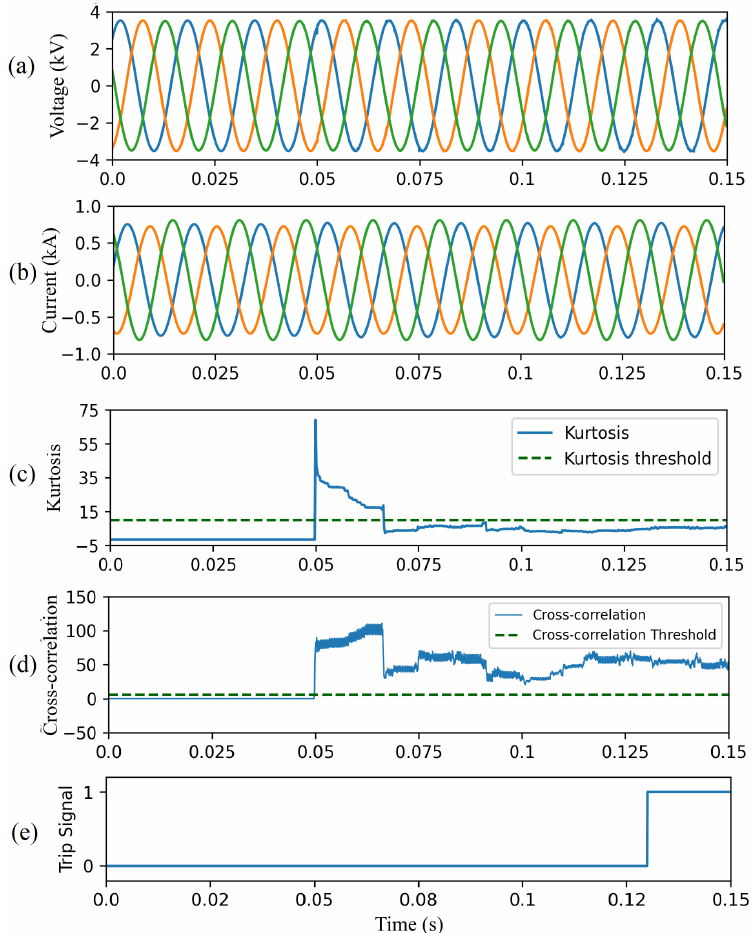
Figure 17. CAE-HIFD performance under 61 Hz fundamental frequency: ( a ) three-phase input voltages, ( b ) three-phase input currents, ( c ) kurtosis, ( d ) cross-correlation, and ( e ) trip